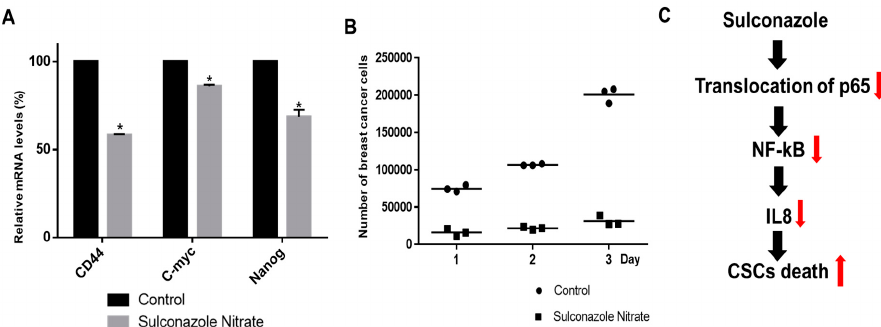
independent experiments;* p < 0.05 vs. the control. ( B ) Sulconazole prevented mammosphere growth. Sulconazole-treated mammospheres were dissociated into single cells and plated in 6-well plates with equal numbers of cells. The cells were counted in triplicate 1, 2, and 3 days after plating and the mean value was plotted. The data shown represent the mean ± SD of three independent experiments. ( C ) The proposed model for CSC death induced by sulconazole is